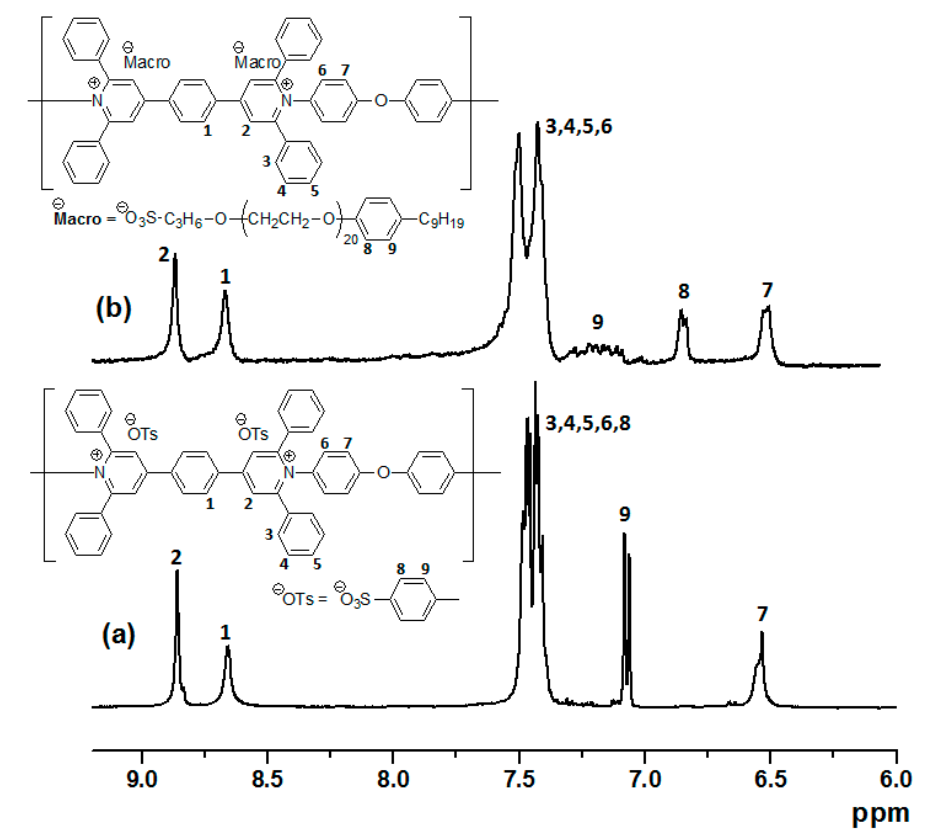
Figure 1. Expanded aromatic regions of 1 H NMR spectra of (a) I-2 and (b) II-2 (10 mg/mL in d 6 -DMSO).